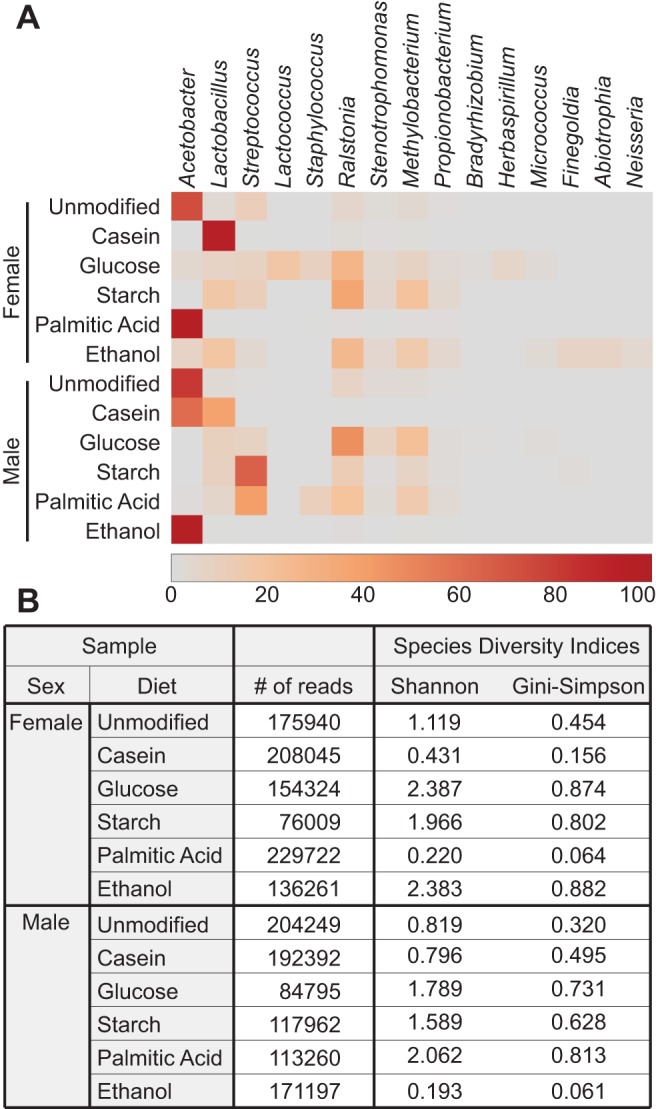
Diet alters intestinal microbial composition. (A) Heat map summary showing abundance of bacterial genera present at greater than 1% in midguts of male and female flies raised on different diets for 10 days. Each sample consists of 5 flies. Abundance of each bacterial genus in a sample ranges from 0% (grey) to 100% (dark red) as indicated by the scale. (B) Summary showing the number of reads from 16S sequencing and the results from both Shannon and Gini–Simpson diversity values of each sample.